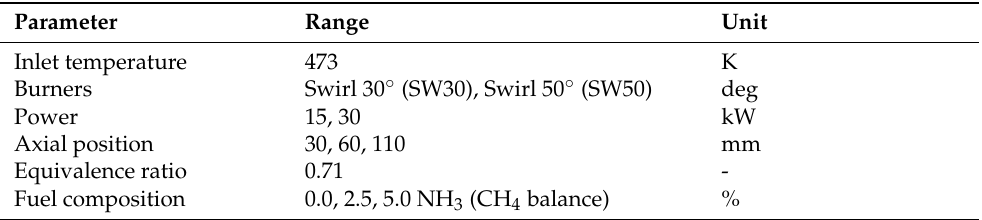
Table 1. Experimental test variables matrix.